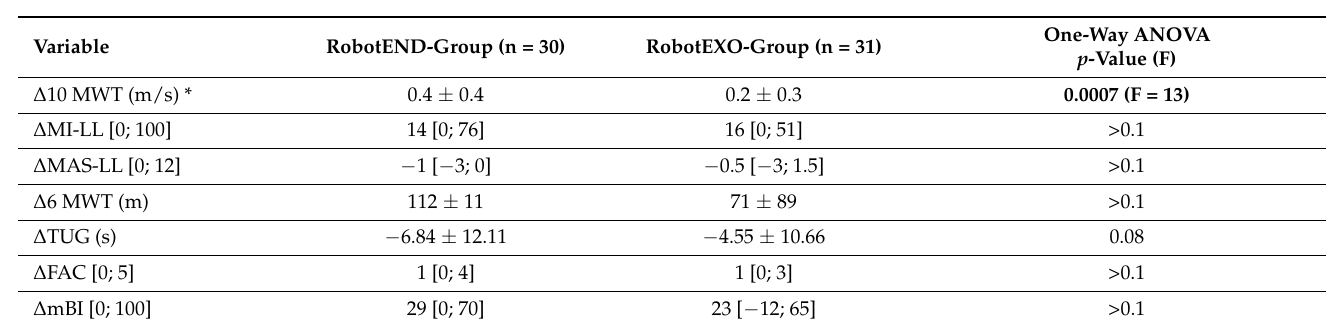
Table 4. Secondary analysis: clinical outcomes of the End-effector Group (RobotEND-group) and Exoskeleton Group (RobotEXO-group) are reported as changes ( ∆ = T1–T0) of functional outcomes and the corresponding one-way ANOVA